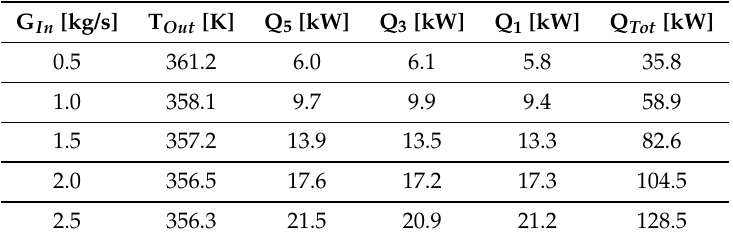
Table 3. Mass-averaged temperature, cylinder-specific and total transferred heat flux for T Cyls = 440 K and